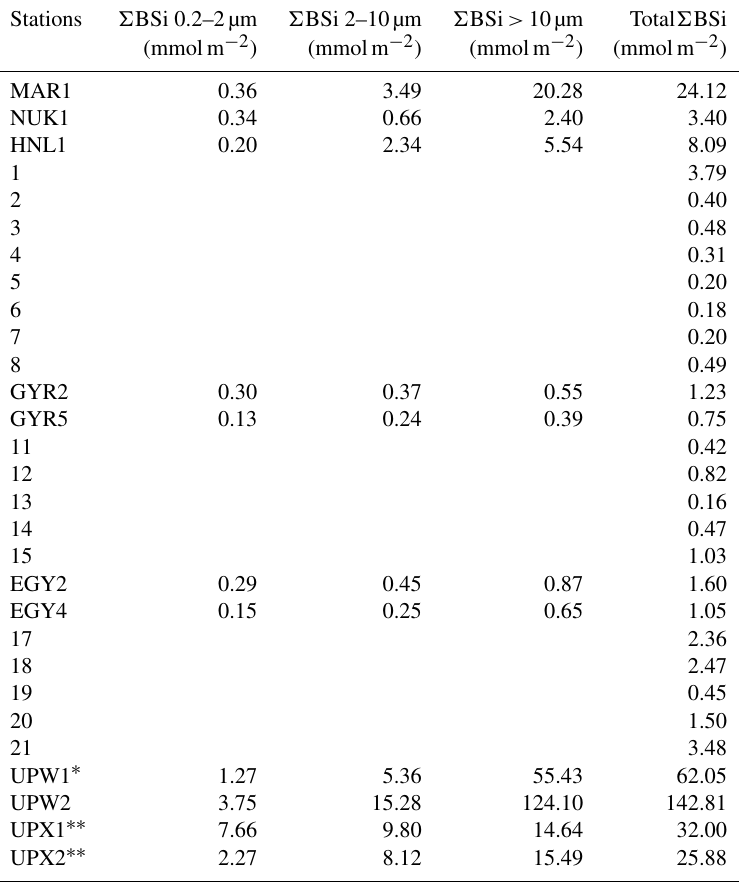
Table A1. Integrated size-fractionated biogenic silica concentrations ( (cid:54) BSi) in the southeastern Pacific (BIOSOPE cruise) over 0–125m (0–50m for ∗ and 0–100m for ∗∗